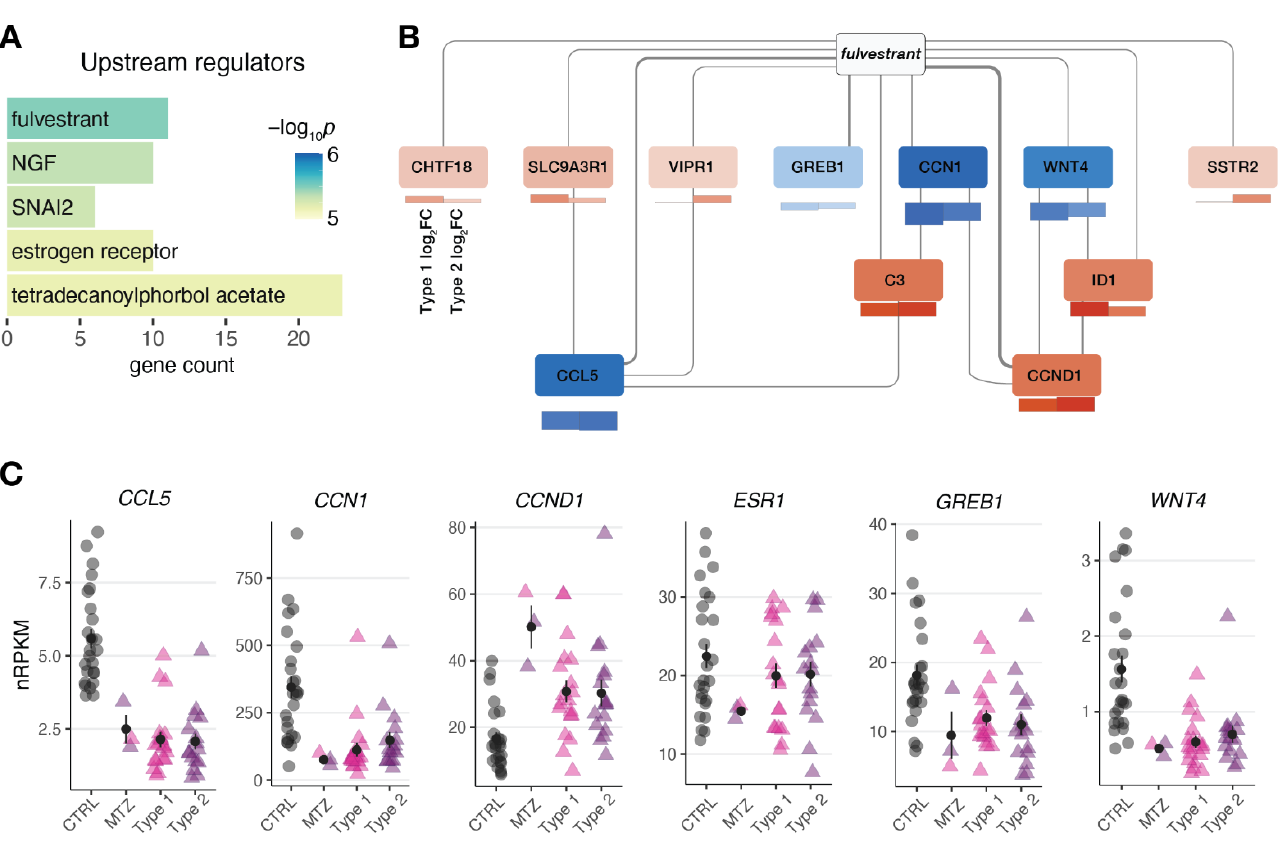
Figure 4. Gene expression changes in MRKH monozygotic twins point at regulators linked to estrogen receptor. ( A ) Predicted upstream regulators for common 174 DEGs (from Figure 3B) based on Ingenuity Pathway Analysis . Top five significant regulators shown. ( B ) Network of DEGs associated with upstream regulator fulvestrant . Interactions based on Ingenuity Pathway Analysis with line width indicating number of curated interactions. Genes color-coded by mean expression change observed in MZT/CTRL on top and SP/CTRL separately for type 1 and type 2 below. ( C ) Expression levels for the selected DEGs plotted as individual data points with mean ± SEM.